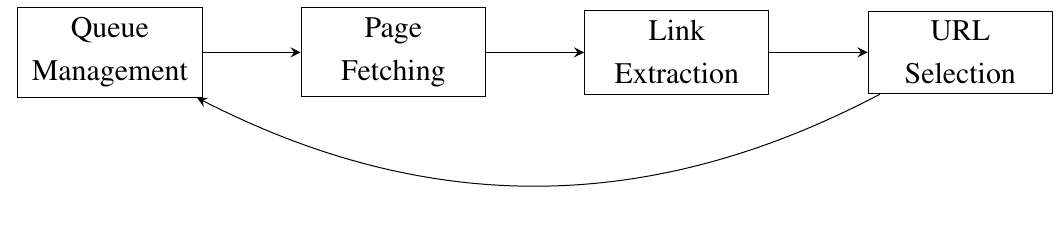
Figure 1. Traditional processing chain of a Web